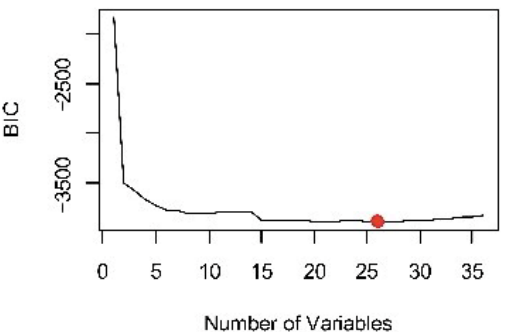
Figure 6. Generalized Additive Model. Number of prediction variables of optimal model under the BIC criterion. The red dot is the best number of variables.